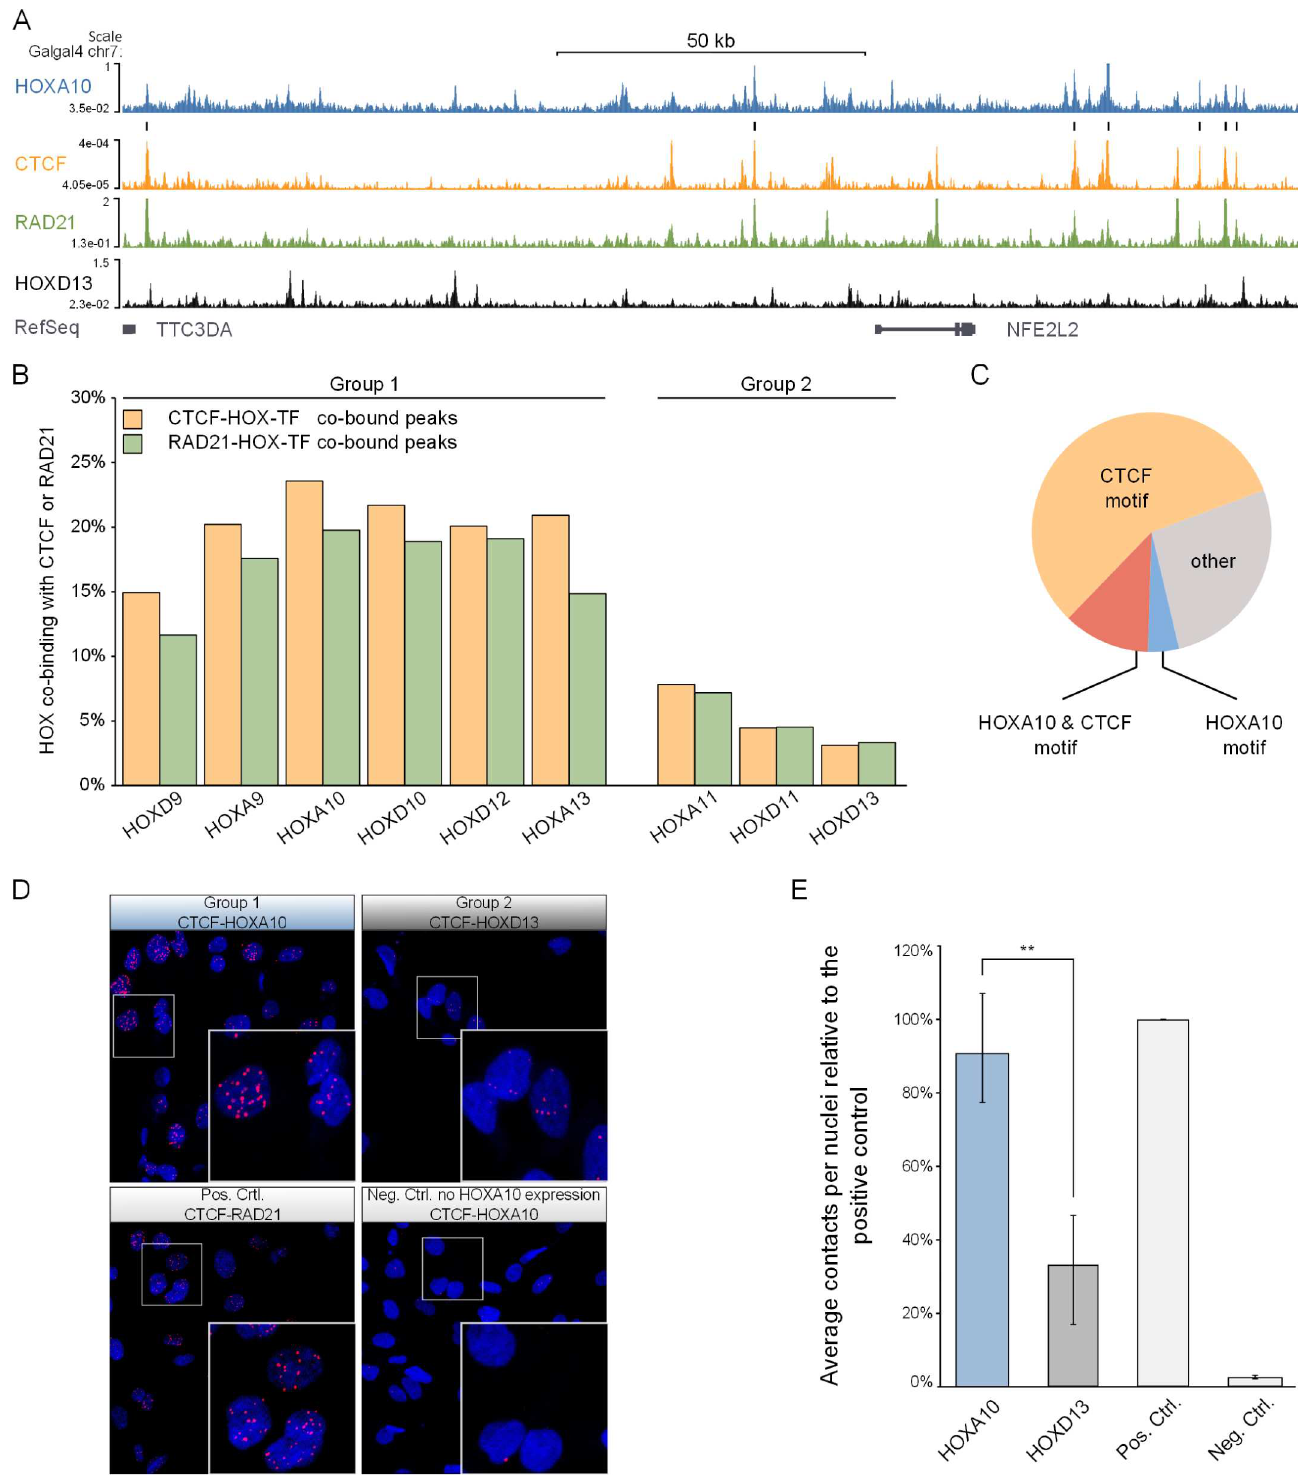
Fig 4. Group 1 HOX-TFs and CTCF/RAD21 share thousands of binding sites throughout the genome. (A) ChIP-seq tracks of HOXA10, CTCF, RAD21, and HOXD13. Black bars abovethe CTCF-track indicateHOXA10/CTCF co-boundsites. (B) Percentageof HOX-TF peaks overlappingwith CTCF (yellow)or RAD21 (green)peaks. (C) The presenceof HOXA10 and CTCF bindingsites in the HOXA10-CTCF co-boundpeaks. (D,E) Proximity LigationAssay (PLA) in DF1 chicken fibroblasts. (D) Top row: DF1 cells expressing3xFLAG-HOXA10 (left) or 3 x FLAG-HOXD13 (right). PLA